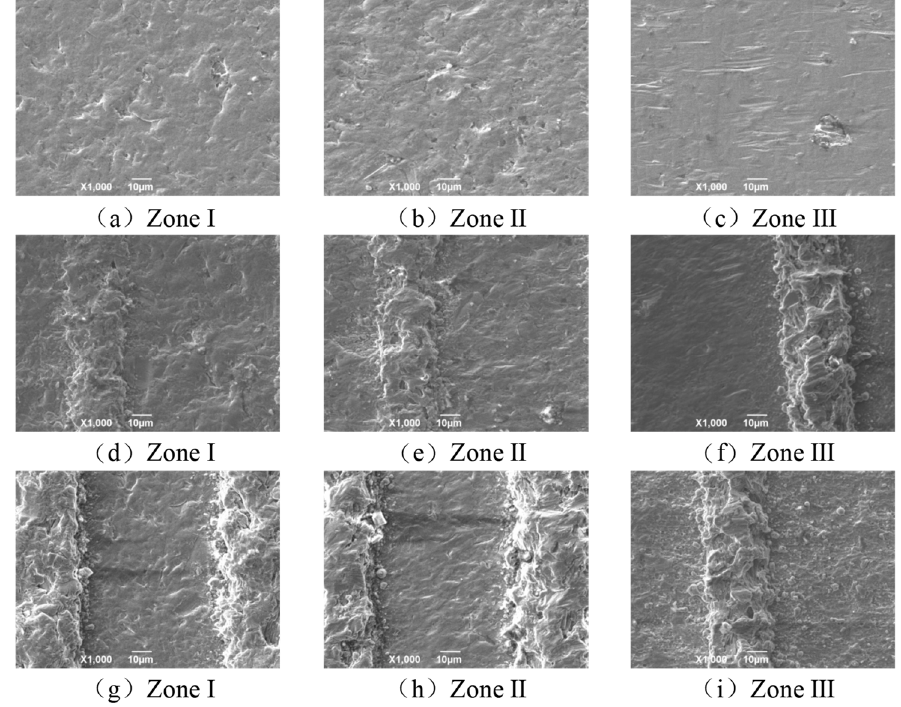
Figure 9. Erosion morphology of samples without laser treatment and laser textured samples with different wettabilities: ( a – c ) the samples without texturing treatment; ( d – f ) superhydrophilic surfaces with texture spacing of 150 μ m, respectively; ( g – i ) superhydrophobic surfaces with texture spacing of 150 μ m, respectively.